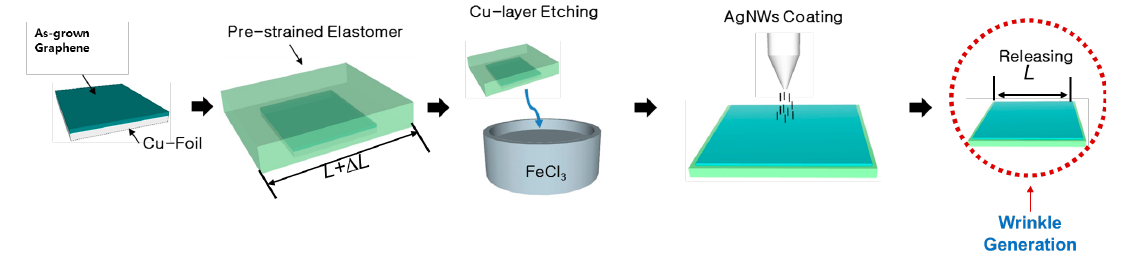
Figure 1. Fabrication process of the wrinkled graphene–AgNWs hybrid electrode.